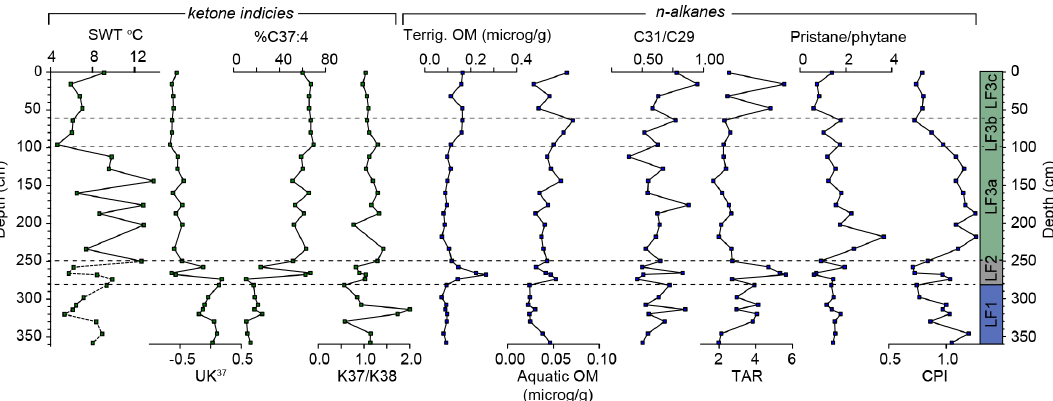
Figure 8. Biomarker ( n -alkanes and ketone indices) data for LC12. Horizontal (dashed) lines delineate the main lithofacies (LF) 1–3. Surface water temperature (SWT) was calculated using data from both D’Andrea et al. (2011) (LF3 – solid line) and Bendle and Rosell-Melé (2004) (LF1 and LF2 – dashed line) for the “lake” and “marine” phases